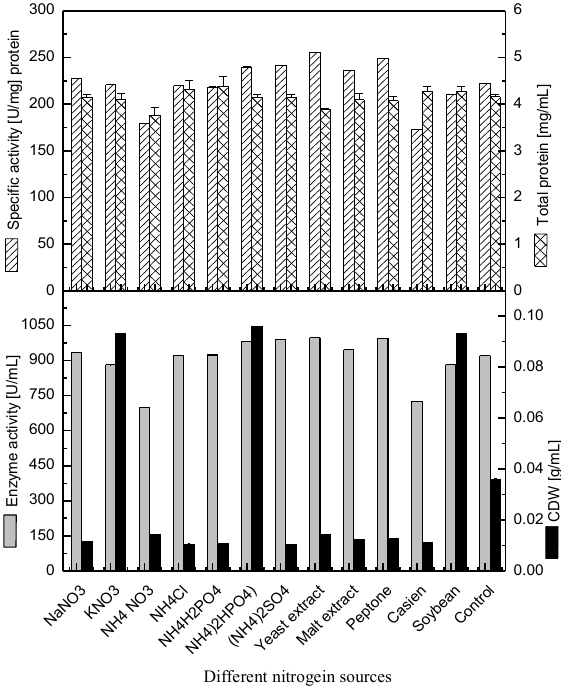
Figure 5. Effect of different nitrogen sources on the production of alkaline protease produced by Str. pseudogrisiolus NRC-15 on 200 rpm at 96 h.